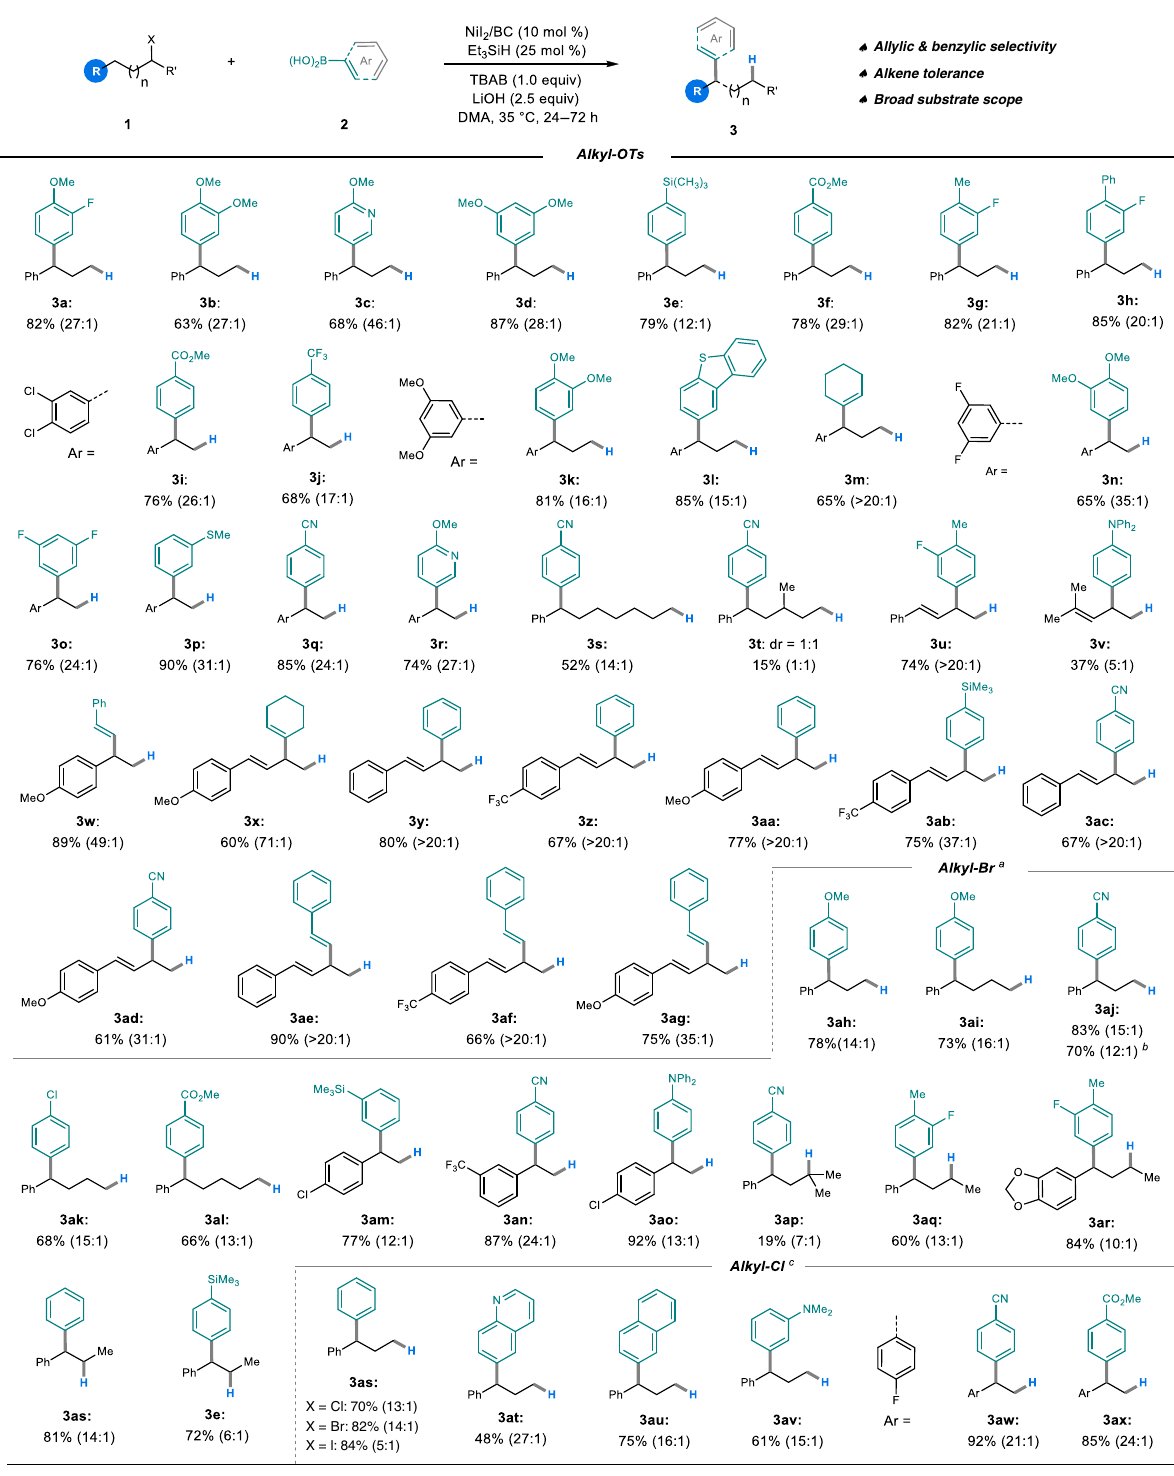
Fig. 2 Scope of the methodology. Isolated yields were shown. Ratios of 3 : 4 are determined by GCMS. a Without TBAB Additive. b 10 mmol scale. c KI (0.38 mmol, 0.75 equiv), LiOH (0.75 mmol, 1.5 equiv), the mixture was stirred at 80